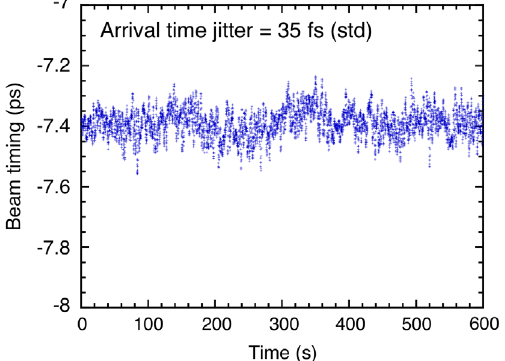
FIG. 13. Beam arrival time jitter measured at the injector exit. The timejitter is35fs (std),which satisfiesthe50-fs ( σ ) targetlimit.